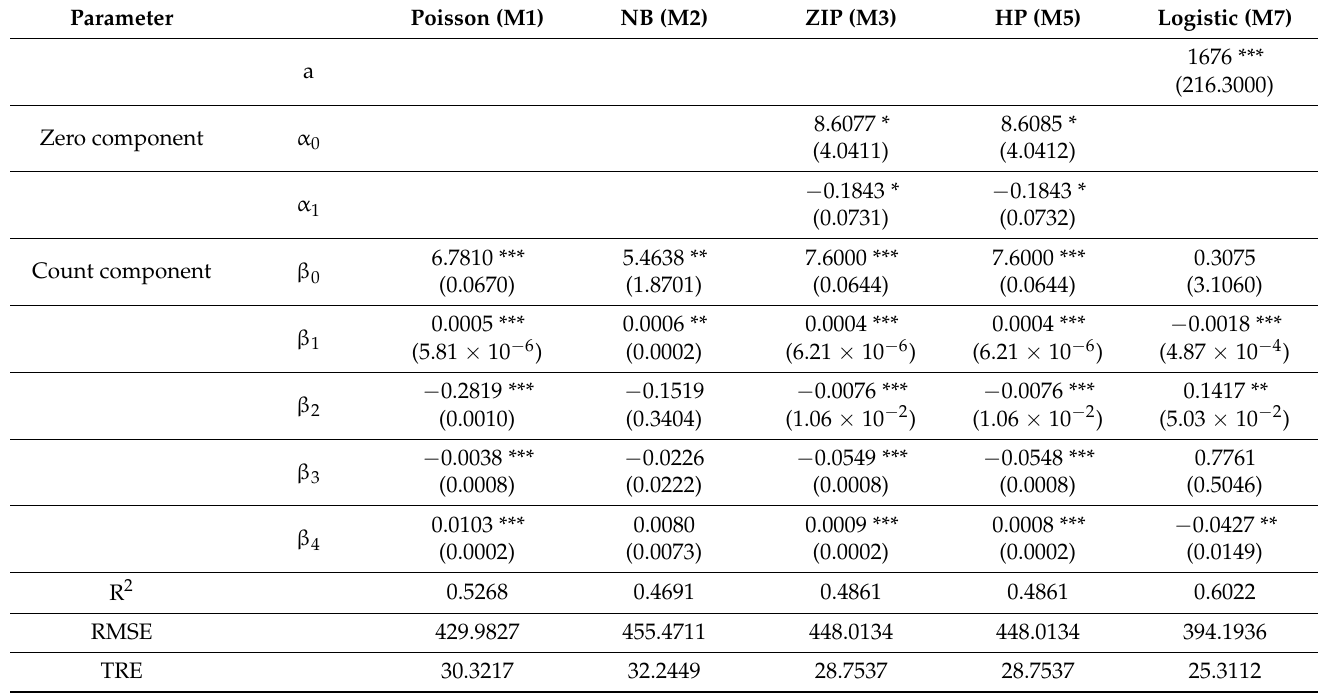
Table 4. Parameter estimates and fit statistics of seven basic models (Equations (1)–(3), (5), and